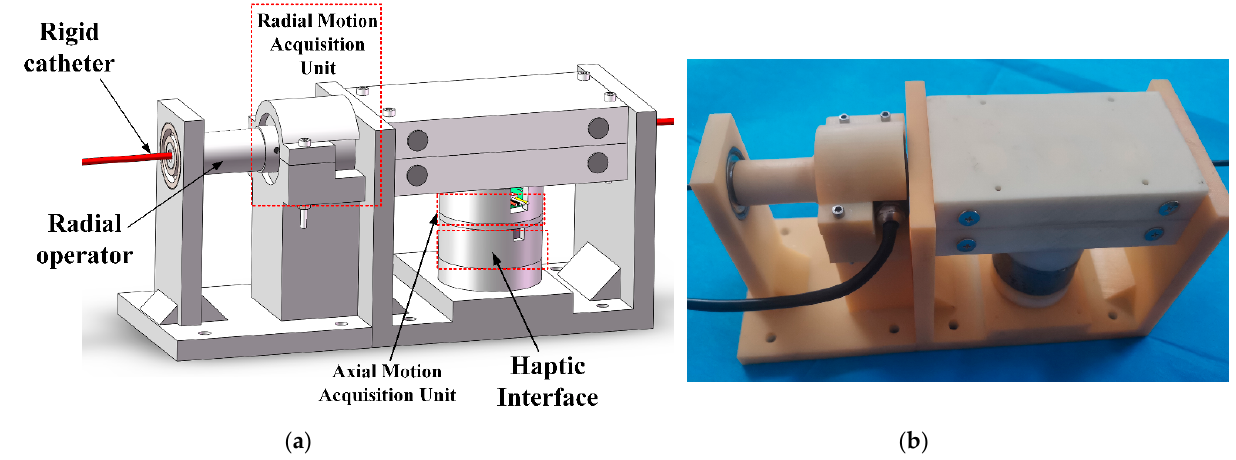
Figure 3. ( a ) Master manipulator CAD drawing. ( b ) Master manipulator physical drawing.